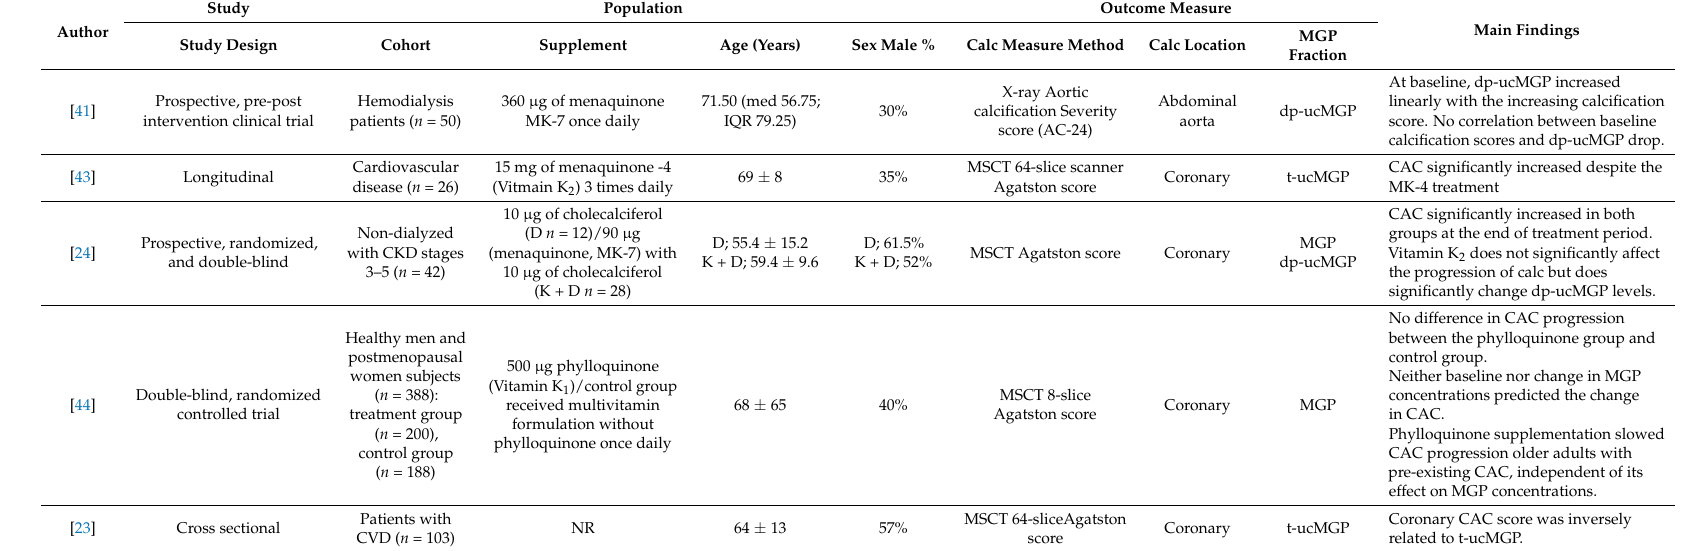
Table 7. Association between MGP fractions and vascular calcification in patients taking vitamin K